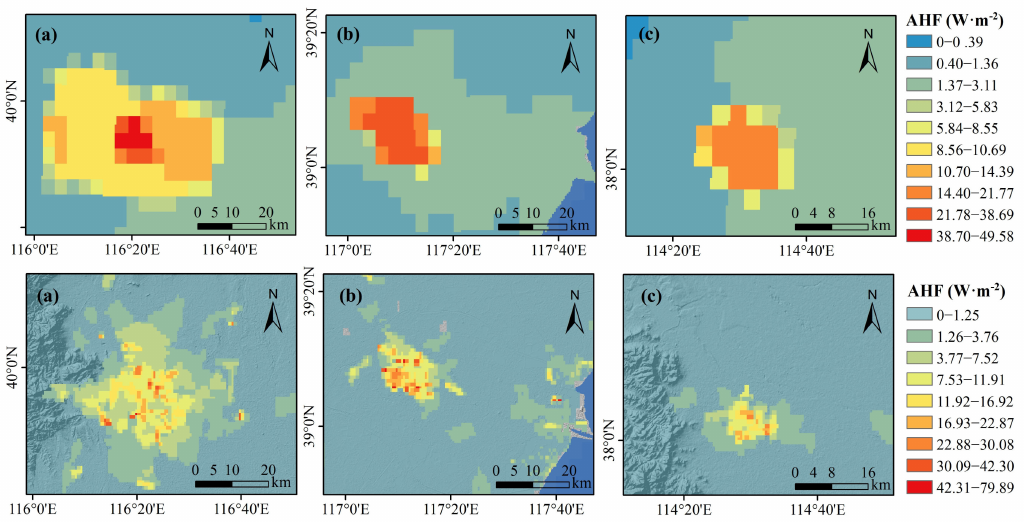
Figure 8. The AHF results of Flanner et al. and the LUCY model. ( a ) AHF results for Beijing city; ( b ) AHF results for Tianjin city; ( c ) AHF results for Shijiazhuang